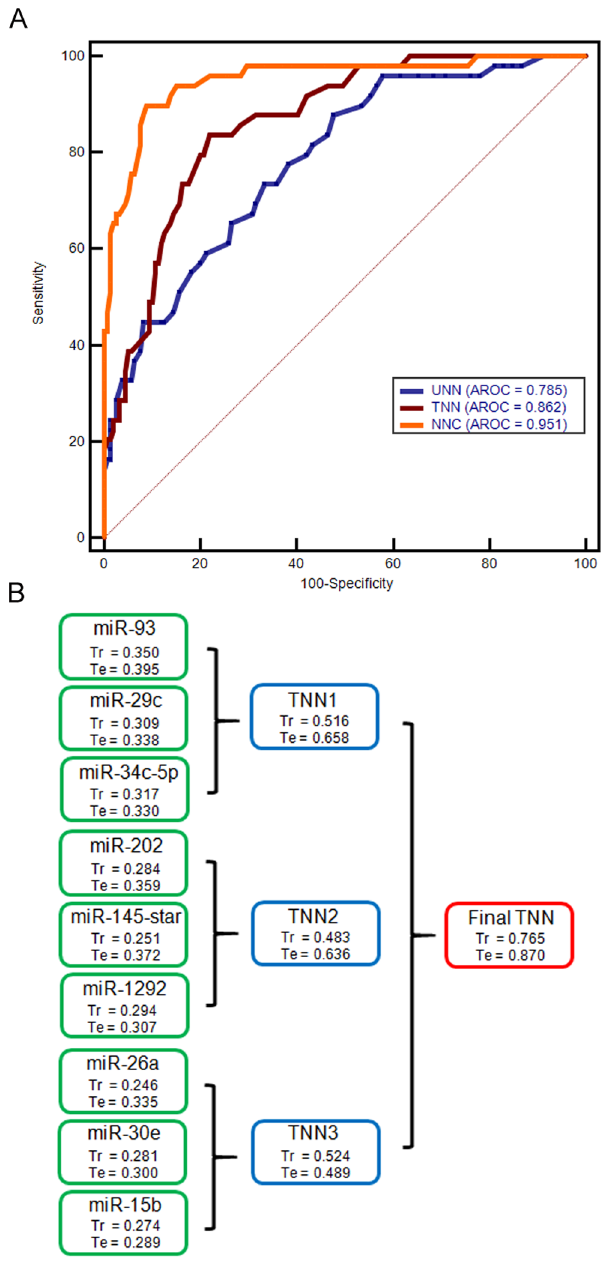
Figure 3. AUROC comparison of three ANN models (A) and results of internal validation of the NNC prediction model (B). UNN: untransformed neural network; TNN: transformed neural network; NNC: neural network cascade. Tr and Te represent correlation coefficients between the output variable and miRNA score of training set and testing set in each ANN unit, respectively. Spearman R values were highlighted: miR-93, miR-29c, miR-34c- 5p, miR-202, miR-145-star, miR-1292, miR-26a, miR-30e, and miR-15b (in descending order of Spearman R value). The miR-93 miRNA score showed the best linear correlation with survival status (Figure 1A, Spearman R = 0.3091). Comparably, the let-7- star miRNA score was found to be unrelated with NPC patient survival (Figure 1B, Spearman R =0.0075). This result was further confirmed by our ROC analysis (Figure 1C). The AUROC of the